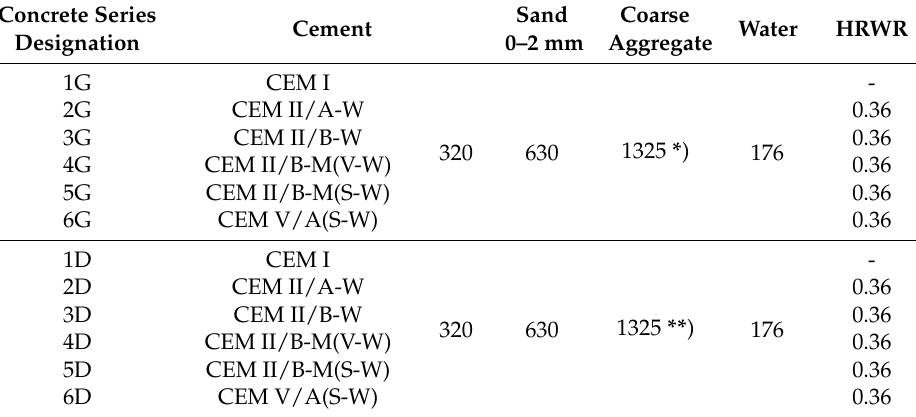
Table 3. Concrete mix design (kg/m 3